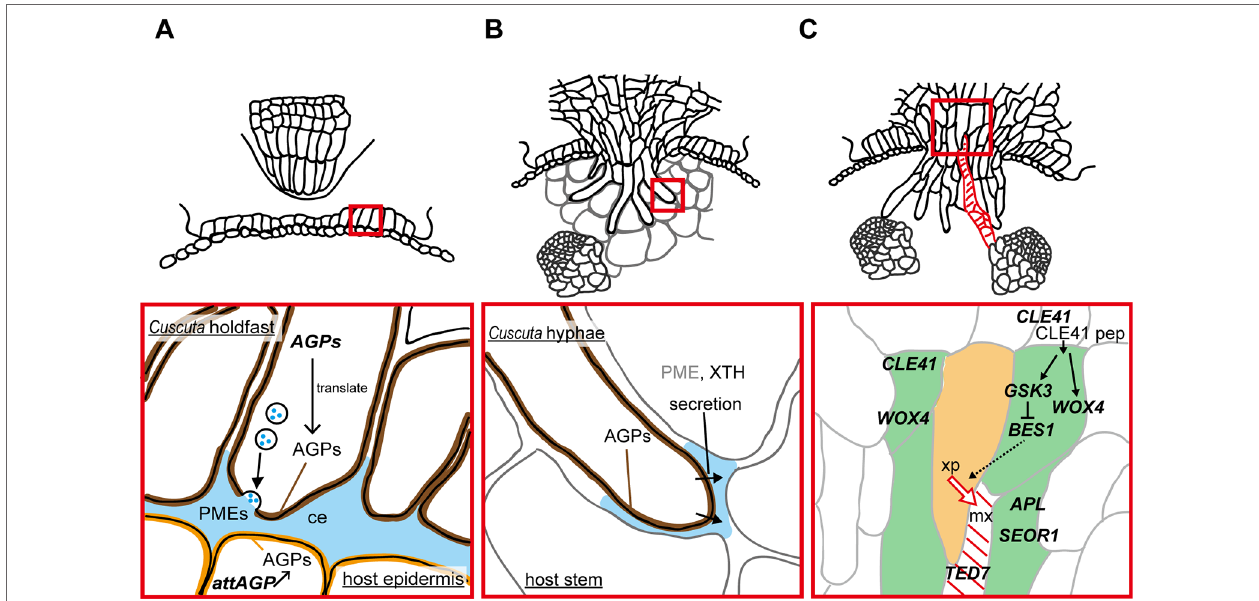
FIGURe 2 | Functions of enzymes and genes associated with the parasitic processes. Panels in the bottom show magnified views of the areas in red squares in panels on the top. (A) Putative function of cell wall-modifying enzymes secreted from holdfast in the adhesive phase. Holdfast cells tighten the adhesion by pectin-rich cement (ce, blue). It has been shown that holdfast cells of Cuscuta campestris contain numerous secretion vesicles containing the components of cell-wall-loosening complexes. Pectin methylesterases (PMEs) are probably secreted to tighten the adhesion of Cuscuta to host. Specific members of genes encoding arabinogalactan proteins ( AGPs ) are expressed in searching hyphae, and accumulate AGP proteins (brown). AGP also have roles in host cell surface (orange) in the adhesion of parasite (Albert et al., 2006). (B) Secretion of cell wall-modifying enzymes to the cell walls adjacent to searching hyphae in the intrusive phase. Xyloglucan endotransglucosylation (XET) activity of XTH was detected in interface (blue) at the tip of haustoria of C. reflexa (Olsen and Krause, 2017). In C. campestris, searching hyphae-specific expression of FASCICLIN-LIKE genes causes the accumulation of AGPs in the interfacial cell walls surrounding searching hypha cells (brown) (Hozumi et al., 2017) Exact role of AGPs in the intrusive phase is still unknown. (C) Expression of genes associated with differentiation of vascular elements during the transition from intrusive phase to conductive phase in haustorim of Cuscuta japonica . Green, procambium/phloem region, orange, xylem precursor (xp), red diagonal lines, mature xylem vessel (mx). WOX4 , WUSCHEL RELATED HOMEOBOX 4 ; CLE41 , CLAVATA3/EMBRYO SURROUNDING REGION-RELATED 41 ; GSK3 , GLYCOGEN SYNTHASE KINASE 3; BES1 , BRI1-EMS-SUPPRESSOR 1; TED7 , TRACHEARY ELEMENT